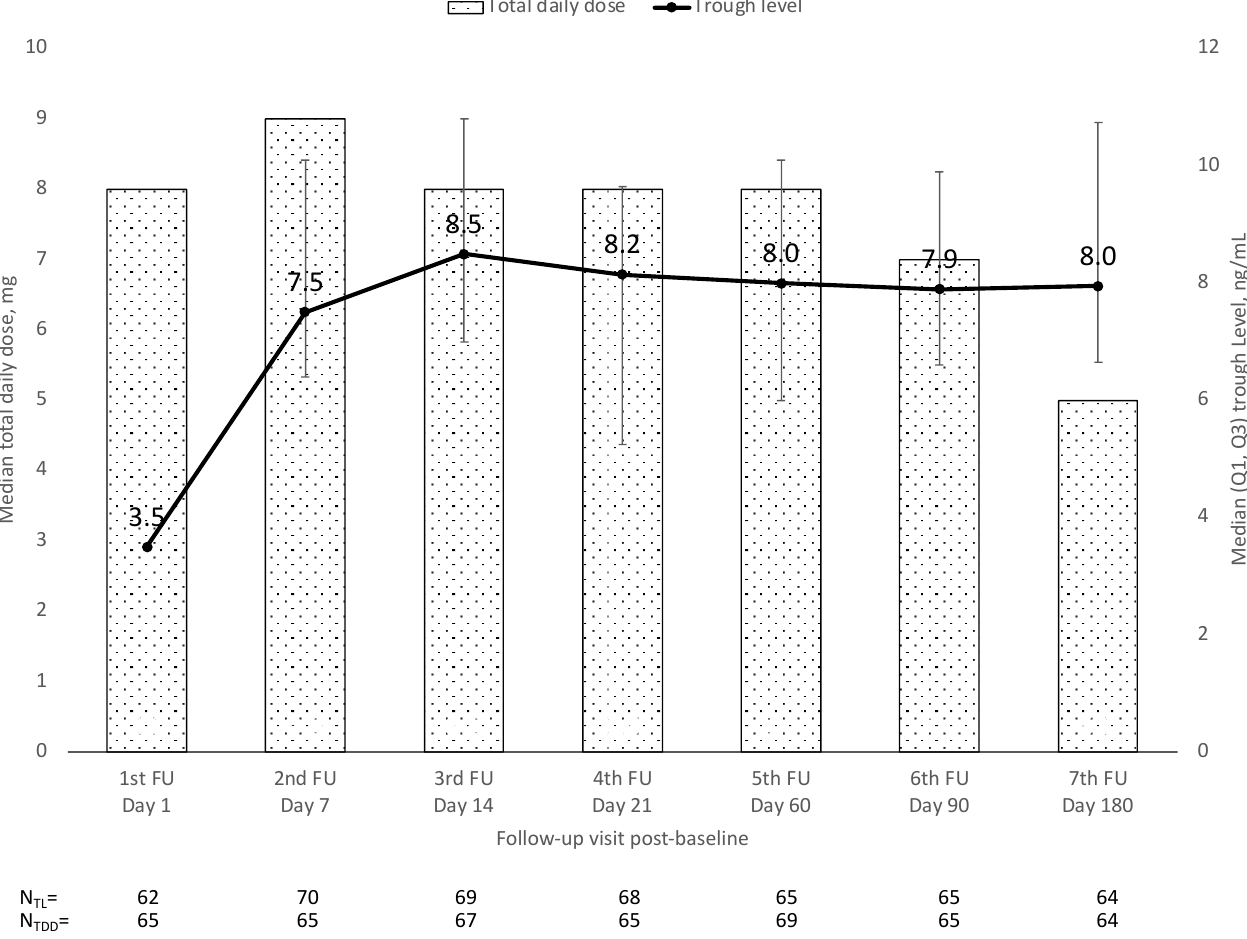
Figure 2. Tacrolimus trough levels and total tacrolimus daily dose over time. TDD = total daily dose; TL = trough level. The time points for each measurement are depicted as per the study protocol and are correlated with the median actual time points. For the analysis, patients were assigned to visit numbers 1 to 8 according to their individual schedules. Note: four patients received prograf (0.5 or 1 mg) during the first 7 days after transplantation because of the required intravenous drug administration during their ICU and/or intubation period before being switched to